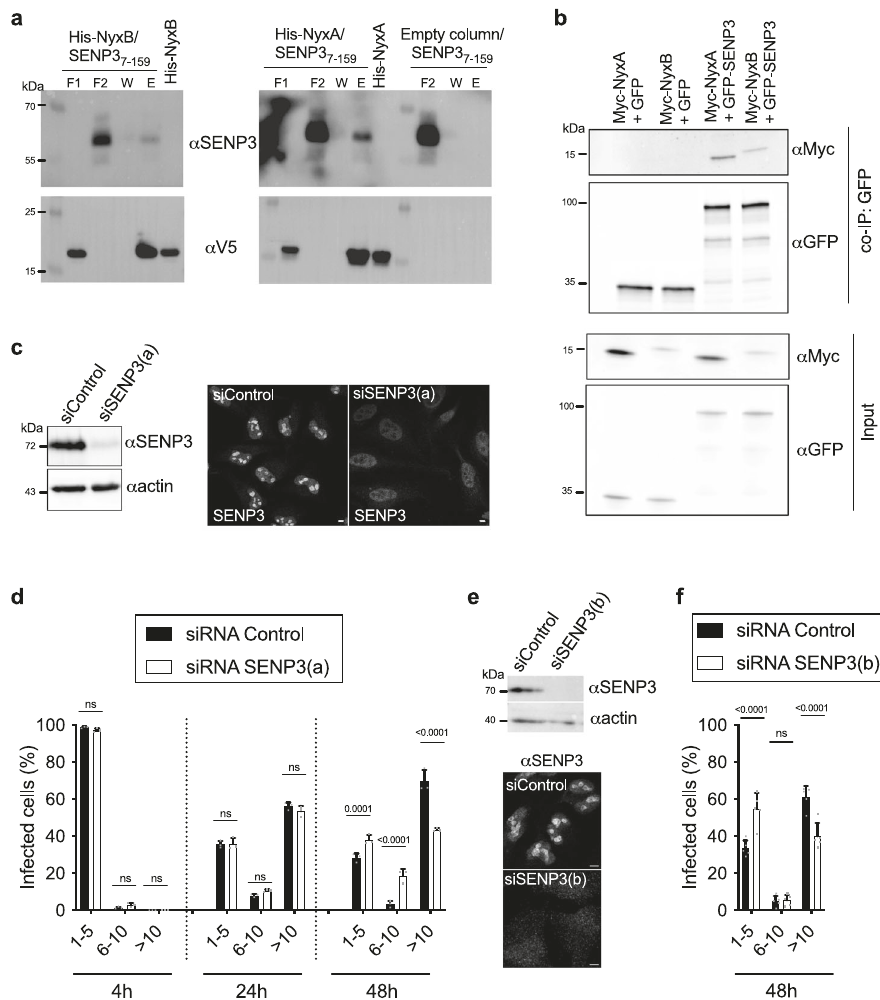
Fig. 2 | The Nyx effectors interact with host protease SENP3, essential for ef fi - cient B. abortus intracellular multiplication. a Pull-down assay with the N-terminalregionofSENP3from amino acid7 until159(SENP3 7-159 ) againstHis-V5- NyxAorHis-V5-NyxBimmobilisedonNiNTAresins.Anemptycolumnwasusedasa control for non-speci fi c binding and puri fi ed His-NyxA and His-Nyx-B inputs are shown. Interactions were visualised by western blotting using an anti-SENP3 anti- body and column binding with anti-V5 (lower blot). Non-bound fractions (F1 and F2), last wash (W) and elution (E) are shown for each sample and the molecular weights indicated (kDa). b Co-immunoprecipitation (co-IP) assay from cells expressing GFP-SENP3 and Myc-NyxA or NyxB. GFP was used as a control for non- speci fi c binding. The co-IP was revealed using an anti-Myc antibody, the fraction bound to GFP-trapping beads with ananti-GFP antibody, and the inputs (shownon the bottom two images) with anti-Myc and anti-GFP antibodies. Molecular weights are indicated (kDa). c Western blot of HeLa cell lysate treated with siRNA control (siControl) or siRNA SENP3 (siSENP3(a)) for 72h. The membrane was probed with an anti-SENP3 antibody followed by anti-actin for loading control. Depletion was